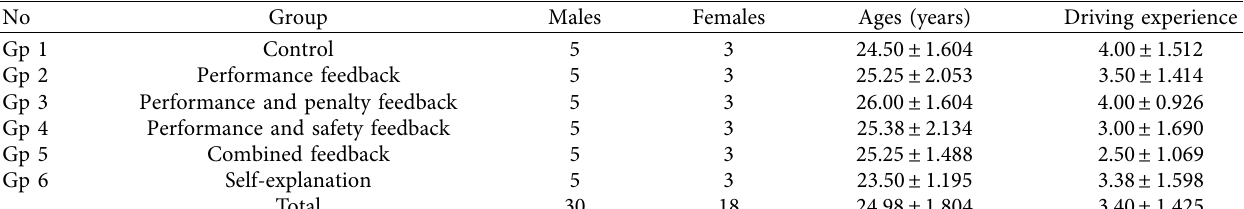
Figure 1: Te methodology adopted by the present study. Table 1: Statistics of the participants in diferent groups.